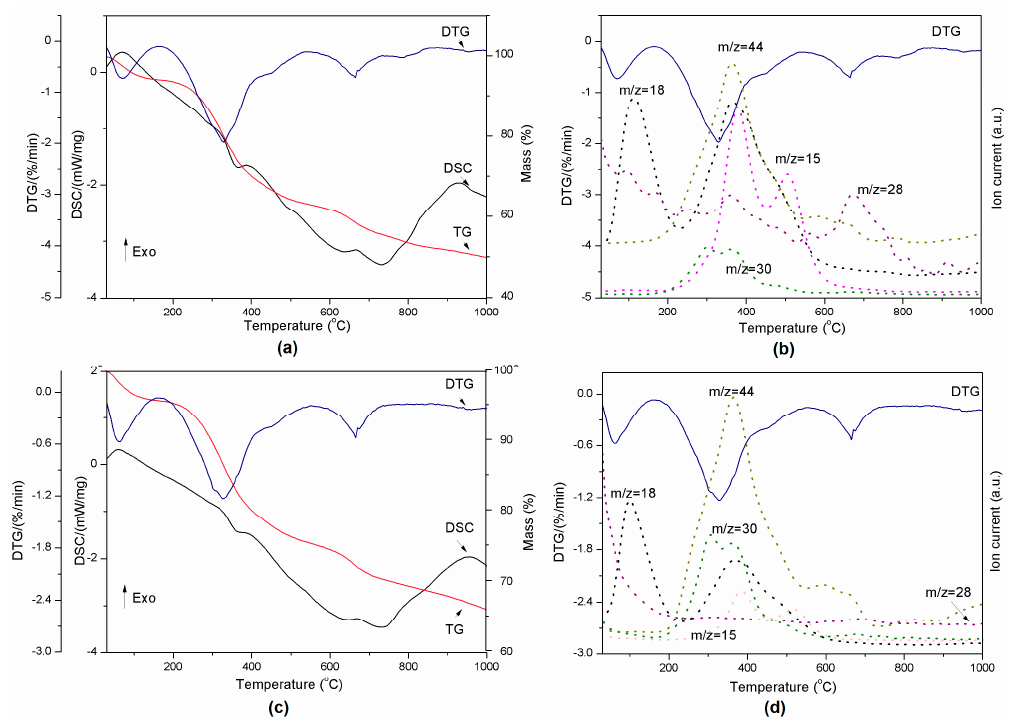
Figure 4. Thermal decomposition of lignin-Al 2 O 3 (8:1, wt / wt ) represented by DSC-TG-DTG ( a ) and DTG-MS curves ( b ) and lignin-Al 2 O 3 (8:6, wt / wt ) represented by DSC-TG-DTG ( c ) and DTG-MS curves ( d ).